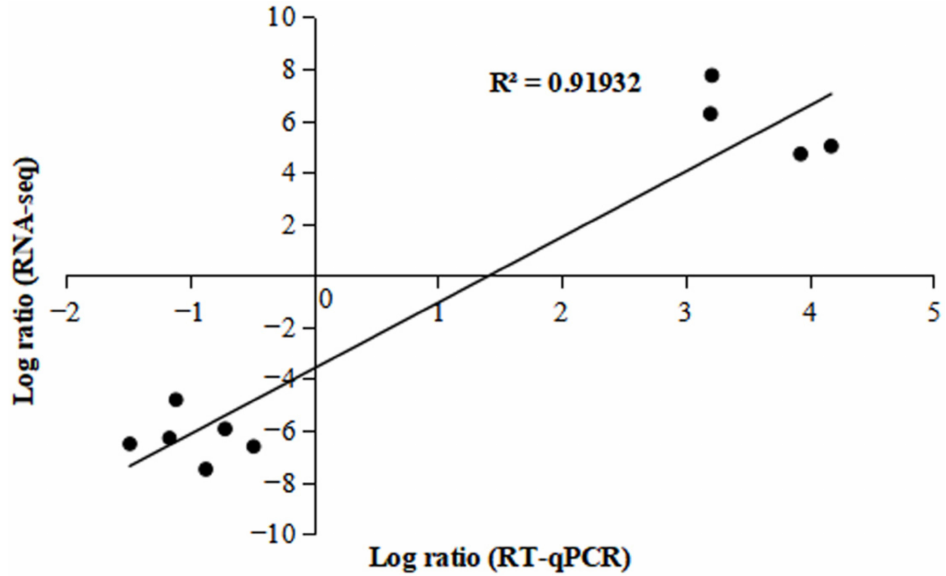
Figure 4. Validation of transcriptomic data (10 DEGs) RT-qPCR. Each black circle represents a gene.